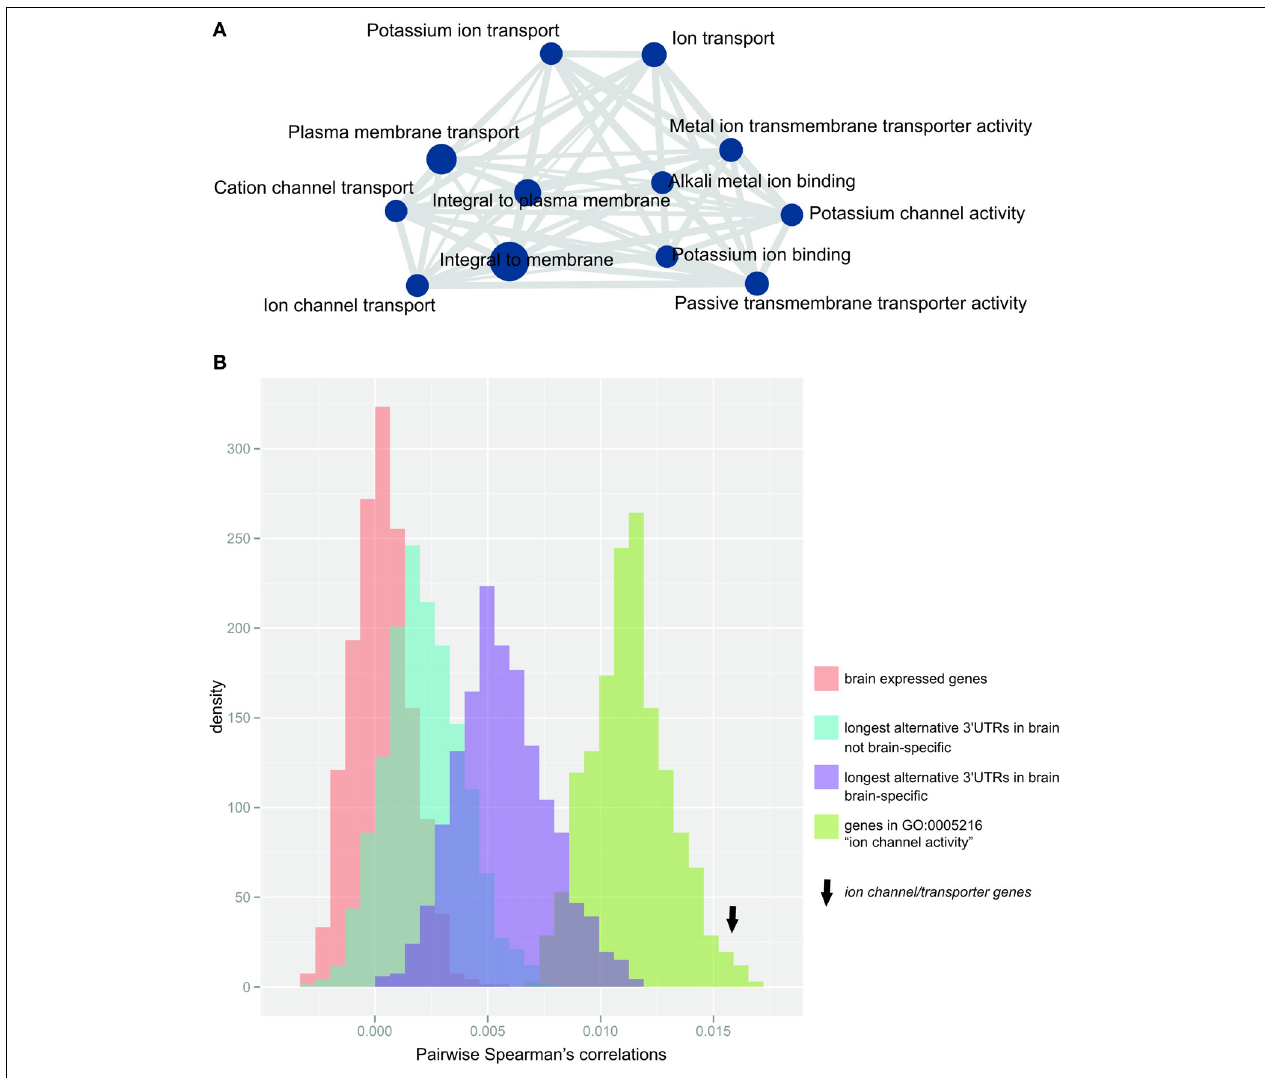
FIGURE 3 | Ion channel/transporter genes are over-represented within genes expressing their longest 3 (cid:2) UTR in the brain (A) Enrichment map (Merico et al., 2010) of significantly enriched GO-terms after terms were summarized using REVIGO (Supek et al., 2011). Node size (blue circles) reflects the number of contributing genes, and edge size (gray lines) corresponds to the number of genes that are shared between nodes. (B) Distribution of the median pairwise Spearman’s correlations for 1000